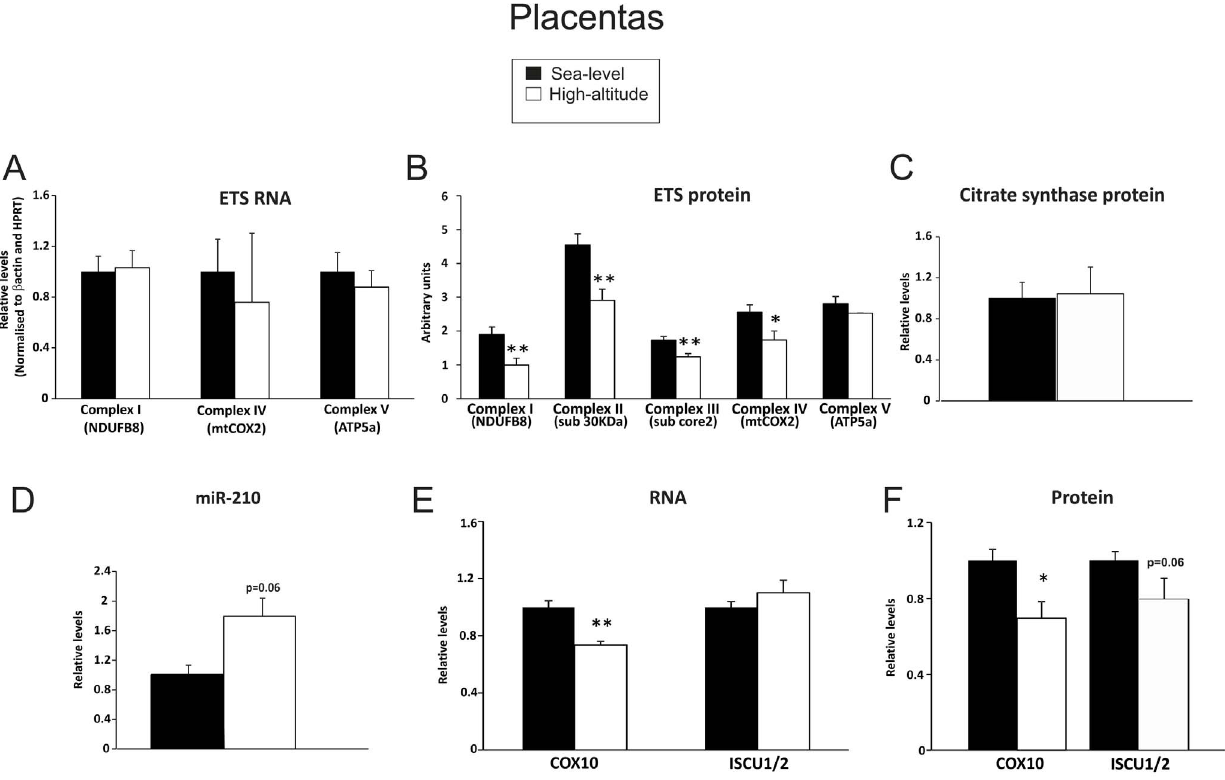
Figure 5. Induction of miR-210, downregulation of ETS, COX10 and ISCU 1/2 protein levels of high-altitude human placentas. A) Transcript levels of ETS complexes I, IV and V (ATP-synthase) and B) protein levels of ETS complexes I-IV and V (ATP-synthase). C) MiR-210 expression in sea-level and high-altitude placentas. D) Transcript levels and E) protein levels of COX10 and ISCU1/2. F) Protein levels of citrate synthase.* p , 0.05 compared with sea-level placentas. Placentas (n=6) at sea level (two tissue samples from different regions of each placenta), and 3 placentas at 3100 m altitude (four tissue samples from different regions of each placenta) were performed. Each sample was carried out at least in duplicate. doi:10.1371/journal.pone.0055194.g005 PLOS ONE |